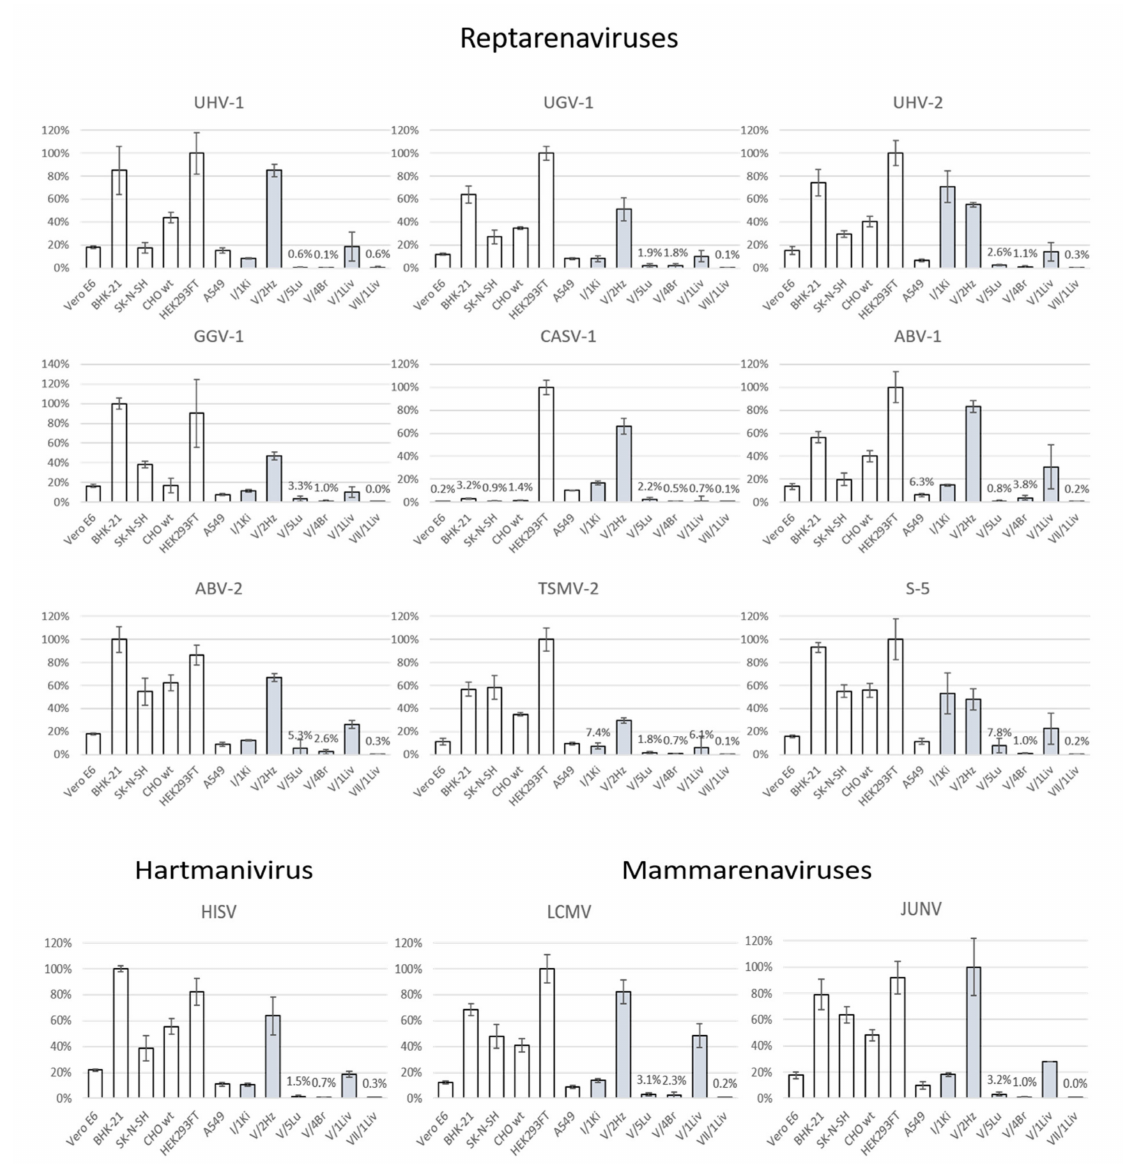
Figure 4. Infectivity of cell lines by pseudotyped viruses, indicating cell count of GFP positive cells. The mammalian cell lines are presented by white bars and the reptilian cell lines by grey bars, the X-axes indicate the individual cell lines and the Y-axes show the permissiveness in relation to VSV-G pseudotypes, expressed as relative percentage in comparison to the most permissive cell line. The values represent the average of four measurements, and the error bars show standard deviation.